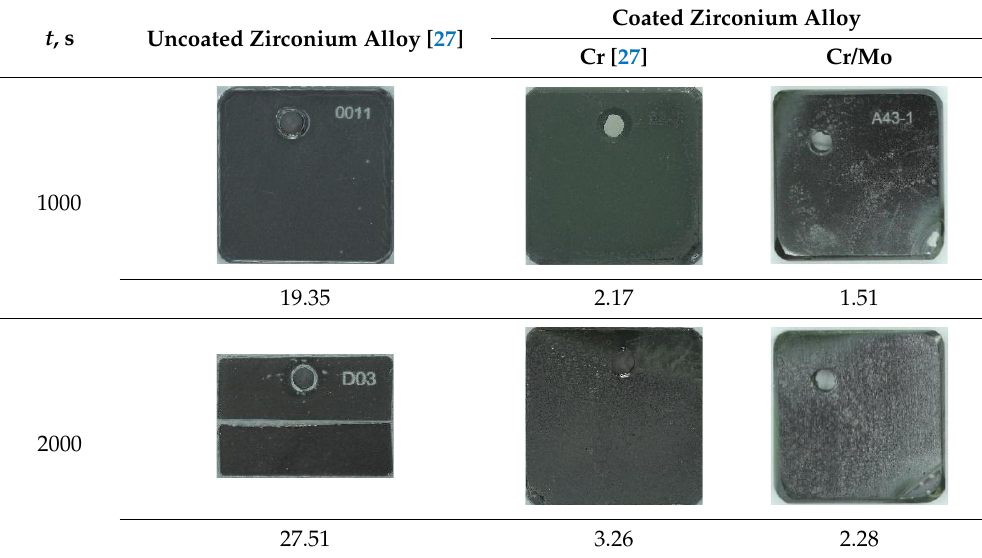
gain after oxidation at 1200 °C compared to the uncoated Zr-1Nb alloy (Table 2). Cr- and